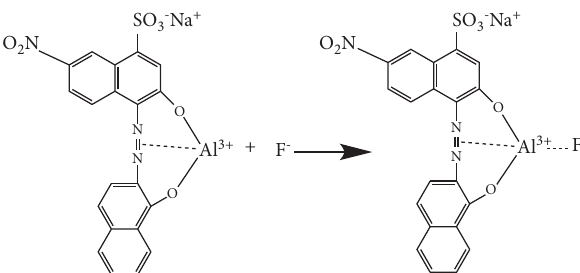
Figure 3: Proposed mechanism of the chemical reaction of Al-EBT with fluoride.